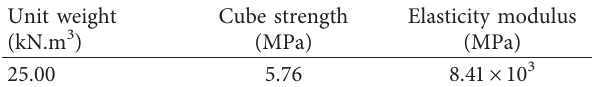
Table 2: Model concrete parameters.